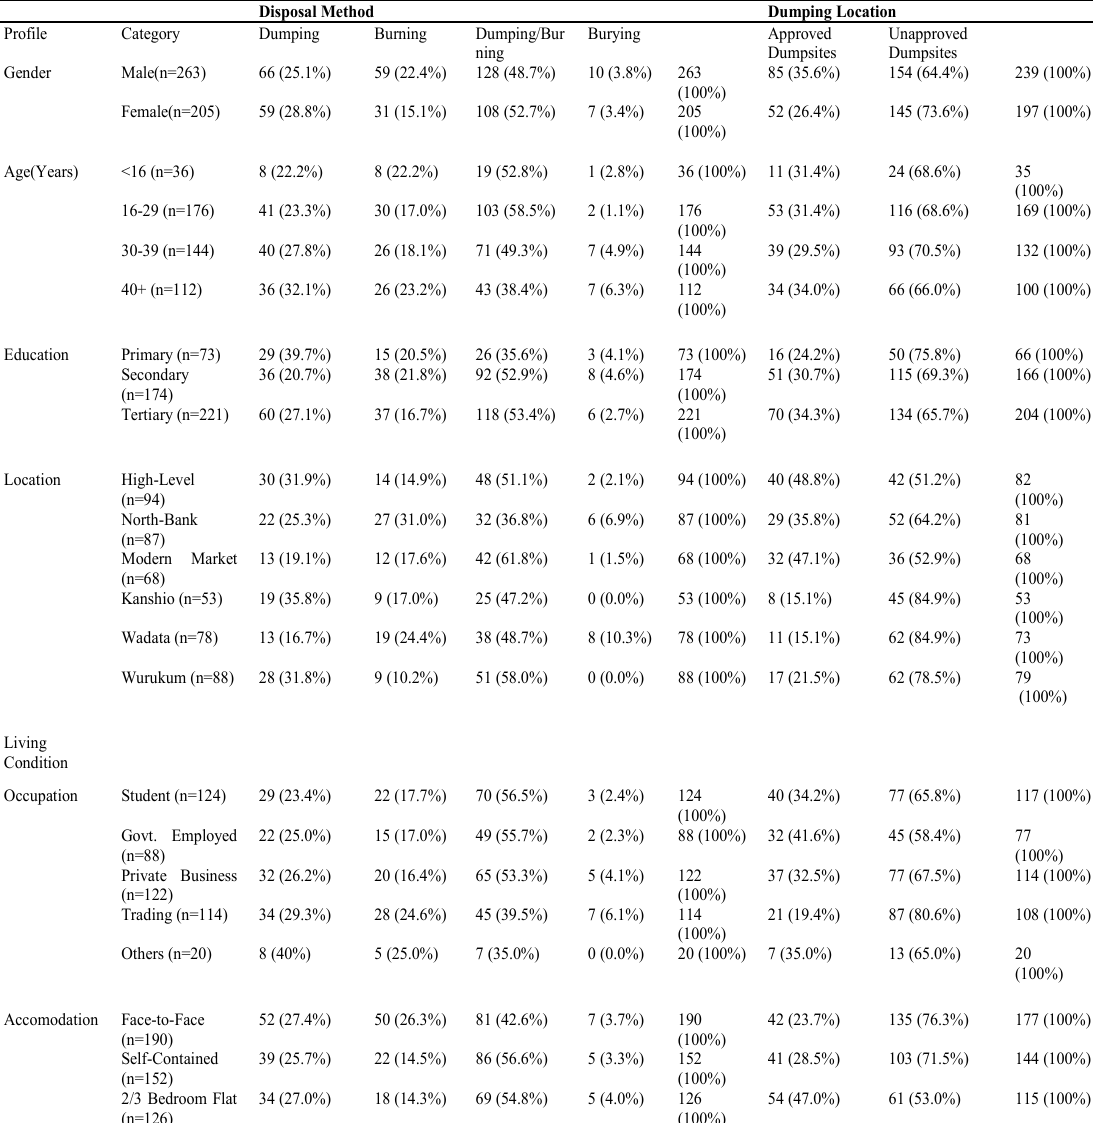
Table 5: Disposal methods and dumping locations for plastic and other wastes in